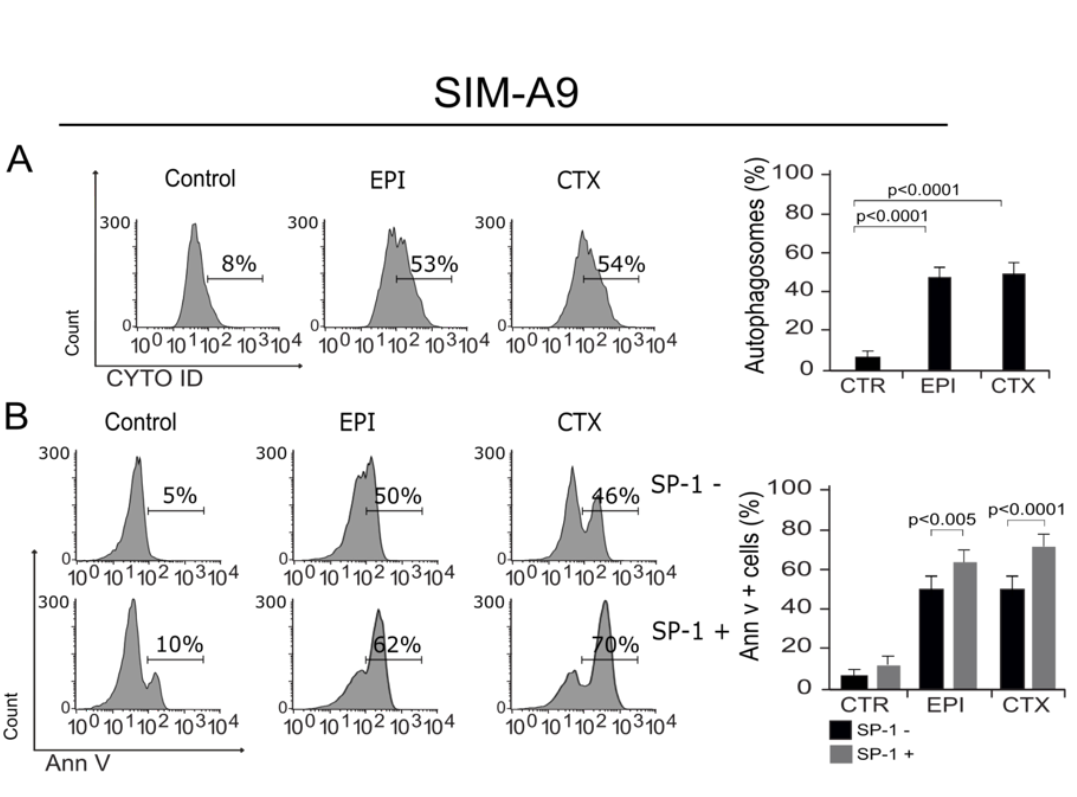
Figure 4: Autophagosome formation and cell death. A ) Representative histogram of autophagy, meas- ured by flow cytometry using Cyto-ID staining in SIM-A9 cells treated with EPI and CTX for 24 hours (left), bars represent the mean  SD (right). B ) Representative histograms showing autophagy involve- ment in cell death, assessed by pre-treating SIM-A9 cells with the autophagy inhibitor, SP-1, and meas- uring cell death by Ann V-positive cells after 24 hours of treatment with EPI or CTX (CC 50 ) (left), bars represent the mean  SD